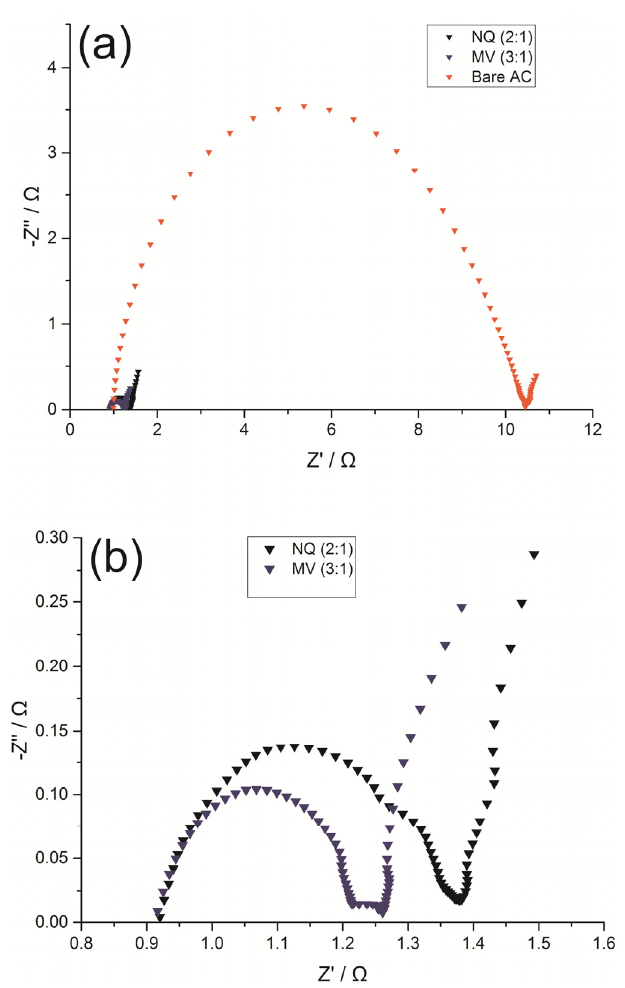
Figure 4. Nyquist plots of EIS by bare AC, NQ/AC (2:1) and MV/AC (3:1) anodes ( a ); as well as the magnified ones ( b ). Table 2. Electrochemical impedance fitting results of different anodes.